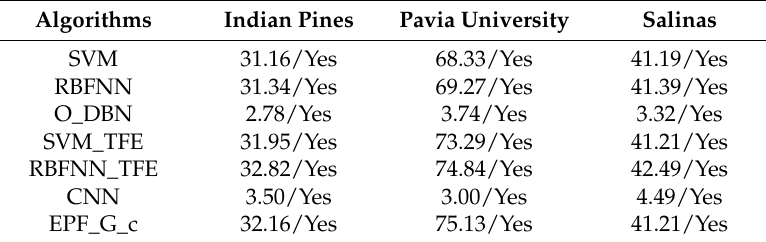
Table 12. ( | z | values/Siginificant?) in the McNemar’s Test.